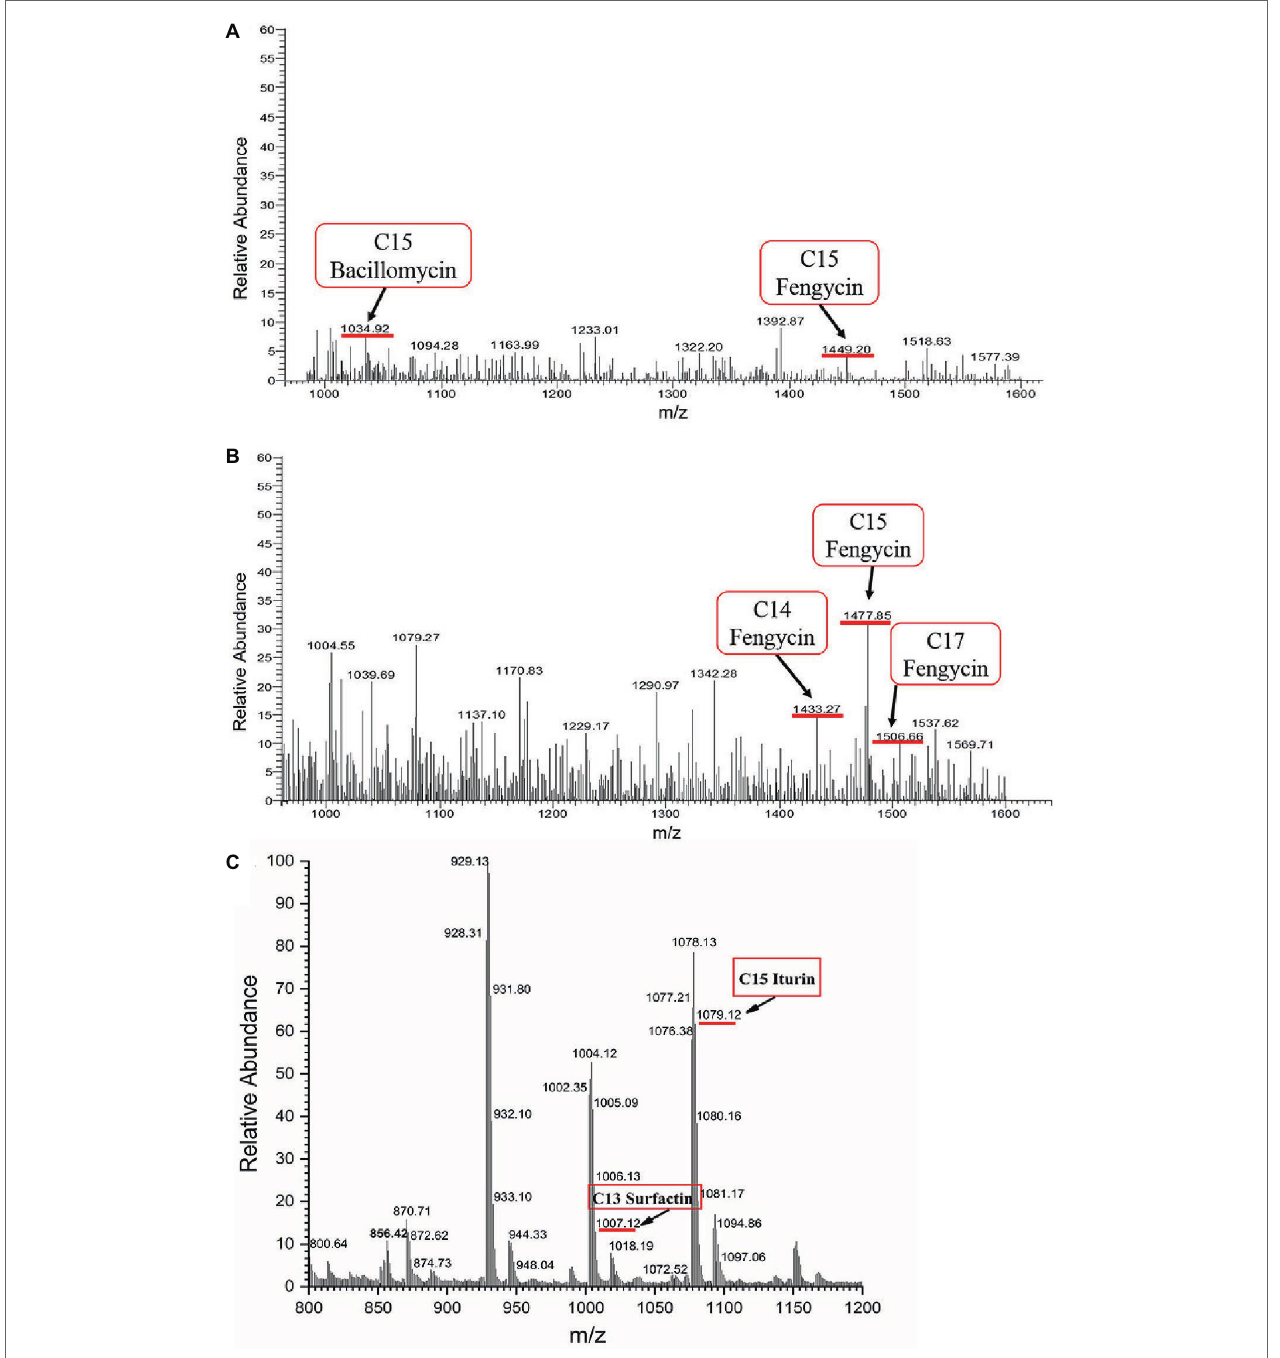
FIGURE 8 | LC-MS/MS analyses on SL-44 crude extracts in different signal peak retention time: (A) 3.72 min, (B) 7.35 min, and (C) 11.89